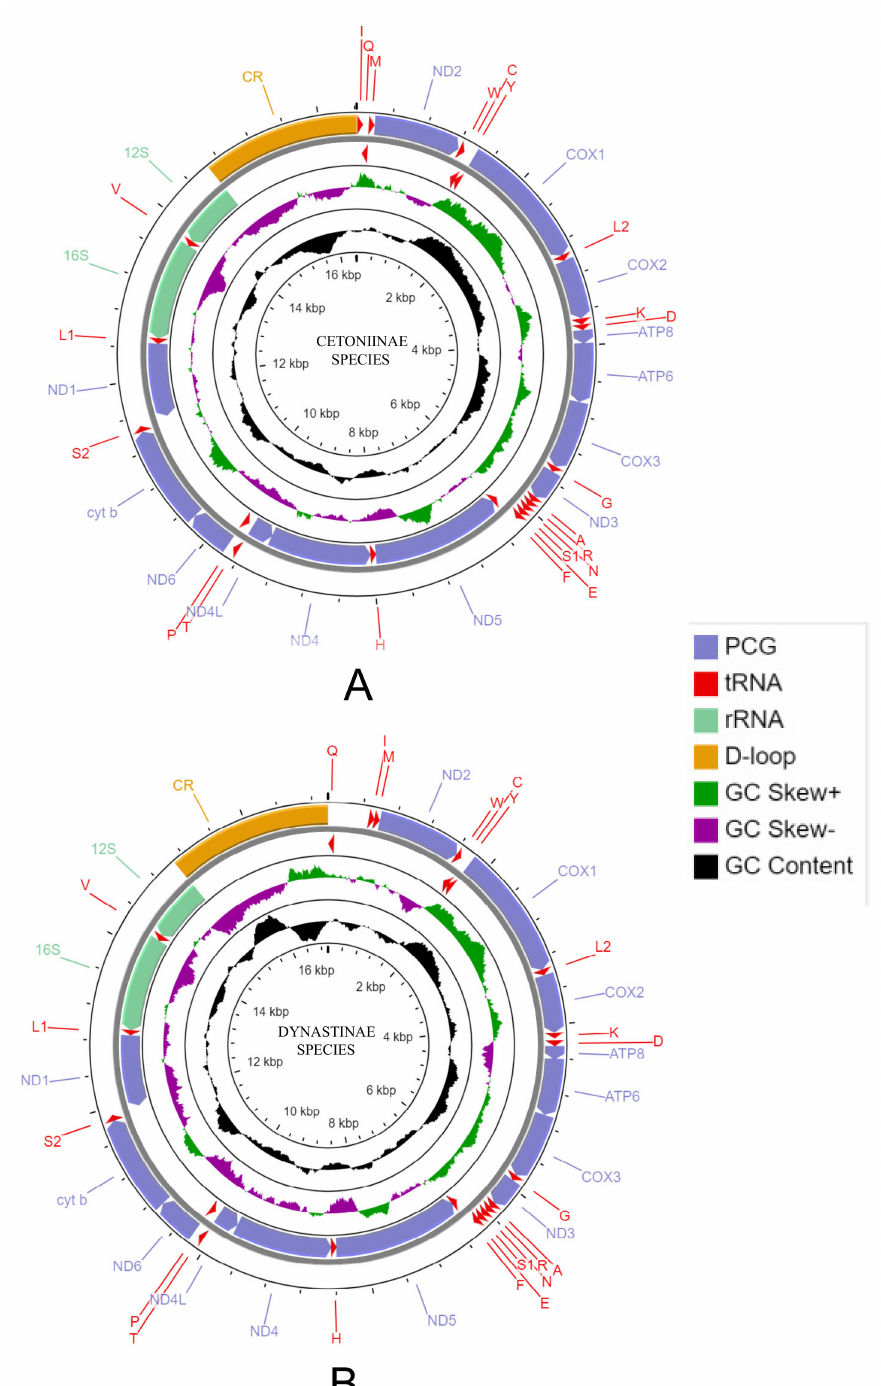
Figure 1. Representative mitochondrial genome maps of Cetoniinae ( A ) and Dynastinae ( B ) species. The first circle shows the gene map (PCGs, rRNAs, tRNAs and the AT-rich region) and the genes outside the map are coded on the majority strand (J-strand) whereas the genes inside the map are coded on the minority strand (N-strand). The second circle shows the GC content and the third shows the GC skew. GC content and GC skew are plotted as the deviation from the average value of the entire